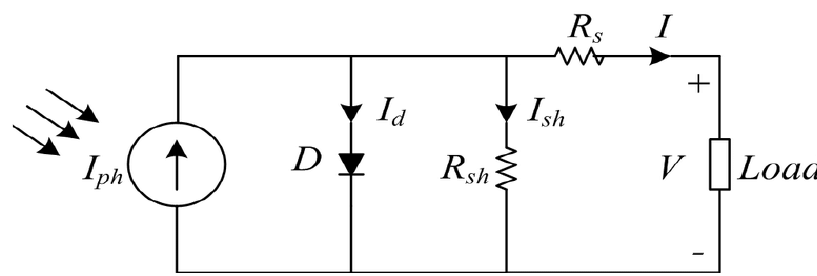
Figure 1. Traditional single-diode equivalent electrical circuit of a solar cell.